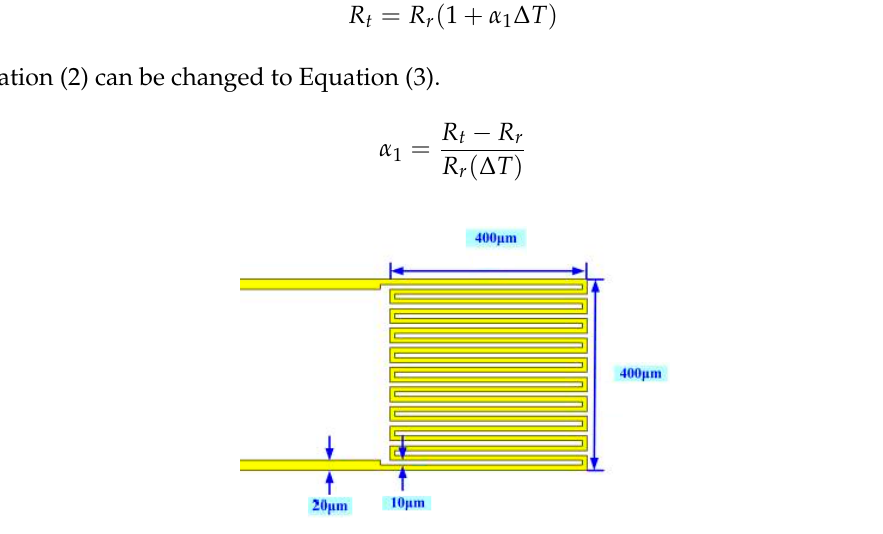
Figure 1. Design of micro temperature sensor.